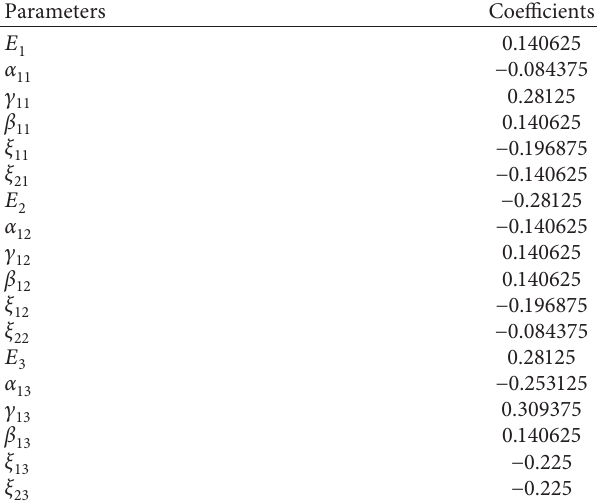
Table 7: The parameters used for the fuzzy-EGARCH-ANN model to simulate data.